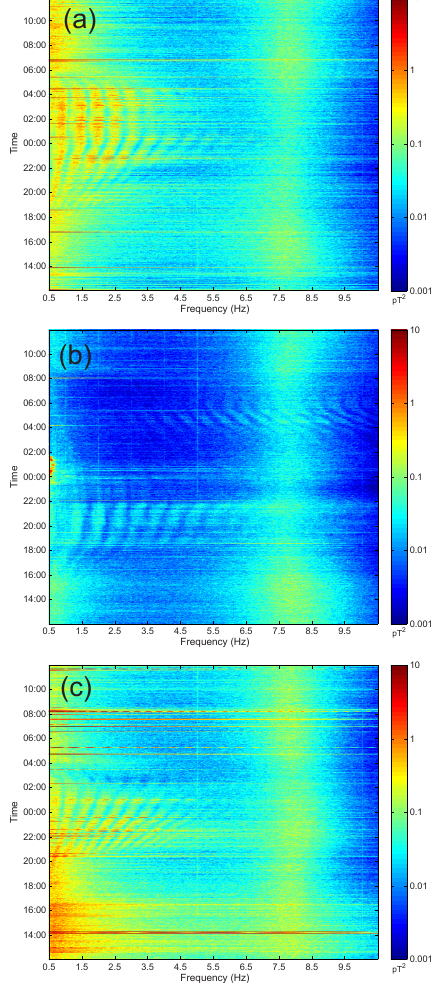
Figure 1. Example spectrograms with clearly visible spectral reso- nance structures from (a) 23–24 September 2012: a typical “good” day with clearly visible SRSs; (b) 11–12 January 2013: SRSs visi- ble at > 7Hz between 03:00 and 06:00; (c) 29–30 July 2013: non- linear fan-shaped